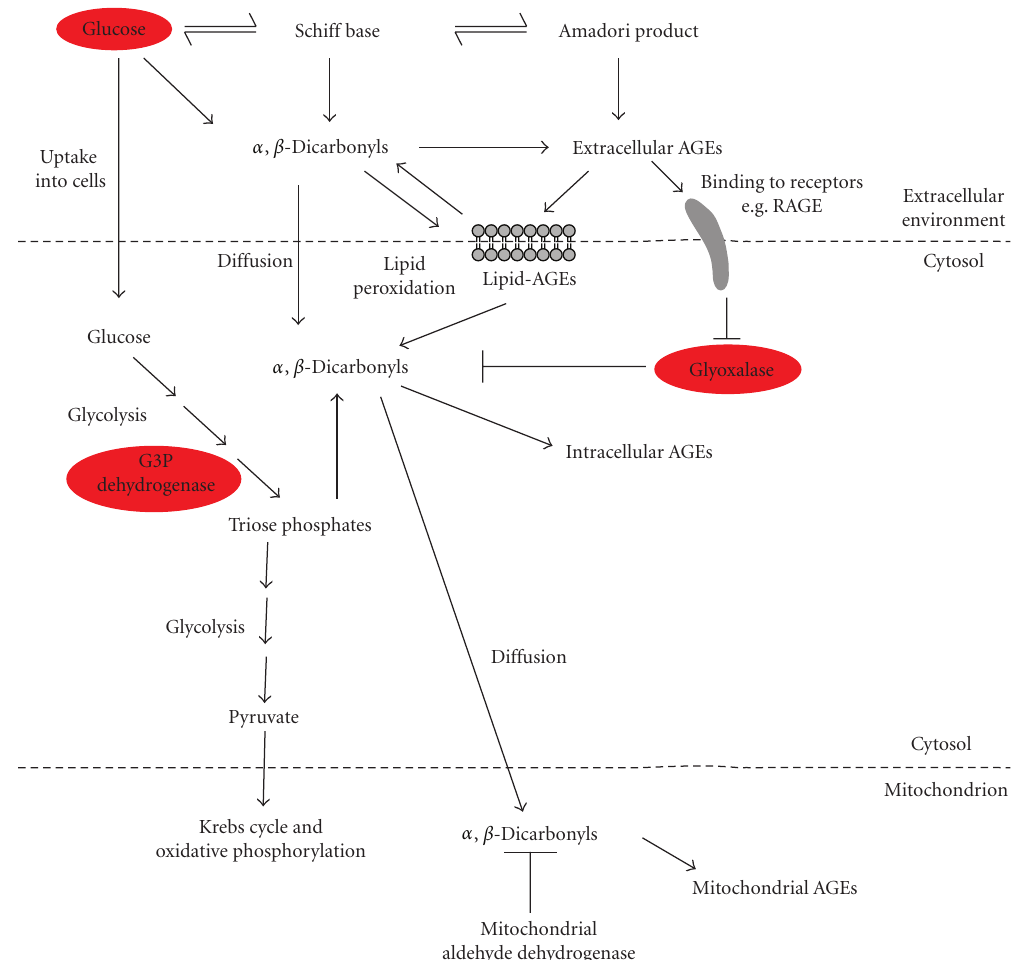
Figure 5: Intra- versus extracellular glycation—involvement in diabetes and ageing. Glycation can take place in the extracellular environment or within cells in the cytosol and in organelles like mitochondria. Extracellular AGEs may arise from oxidative and nonoxidative modifications of the Amadori product or from direct reaction of α , β -dicarbonyls with proteins. Extracellular AGEs may bind to cell surface receptors such as RAGE, thereby activating cell signalling pathways. The formation of lipid-AGEs on the cell surface membrane can further generate reactive α , β -dicarbonyls such as glyoxal. These reactive carbonyl species can di ff use through lipid membranes and enter cells where they react with cellular biomolecules to form intracellular AGEs. They can also di ff use further into mitochondria and similarly cause glycation damage within these organelles. Intracellular glycation may also arise from α , β -dicarbonyls produced during the breakdown of triose phosphates generated during glycolysis. Normally, glycation damage is kept under control by defences such as the glyoxalase enzyme system and aldehyde dehydrogenases. However, in diabetes, glycation damage increases due to elevated formation of α , β -dicarbonyls, arising from high glucose levels and consequent inhibition of the glycolytic enzyme, G3P dehydrogenase, both of which lead to a rise in triose phosphate levels. These in turn break down nonenzymatically to form methylglyoxal, a major precursor of glycation. In addition, activation of RAGE is associated with decreased glyoxalase I expression, which is expected to further raise methylglyoxal levels by preventing its removal. During ageing, glycation damage also increases, but mainly as a result of a loss of glyoxalase activity with